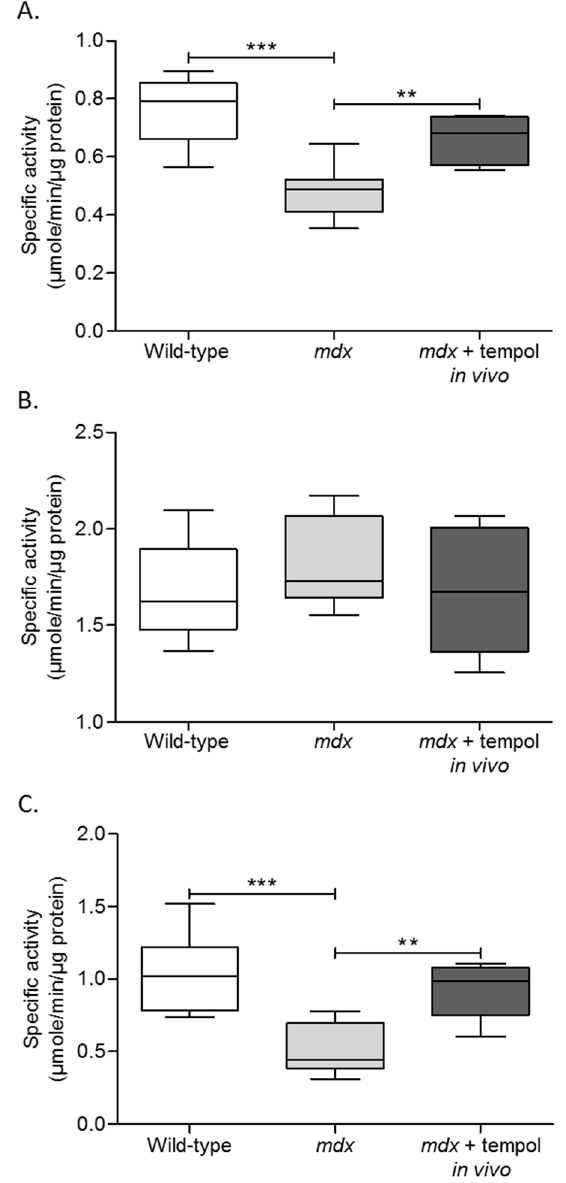
Figure 3. Metabolic Enzyme Activities. Group data for citrate synthase ( A ), phosphofructokinase ( B ), and lactate dehydrogenase ( C ) enzyme activities in diaphragm muscle from wild-type, mdx and mdx + tempol in vivo. mdx + tempol in vivo received 1 mM tempol in their drinking water for two weeks. Values are expressed as box and whisker plots (median, 25–75% centiles and minimum and maximum values), and data were statistically compared by unpaired Student’s t tests. ( A ) *** p = 0.0003; ** p = 0.005. ( C ) *** p = 0.001; ** p =